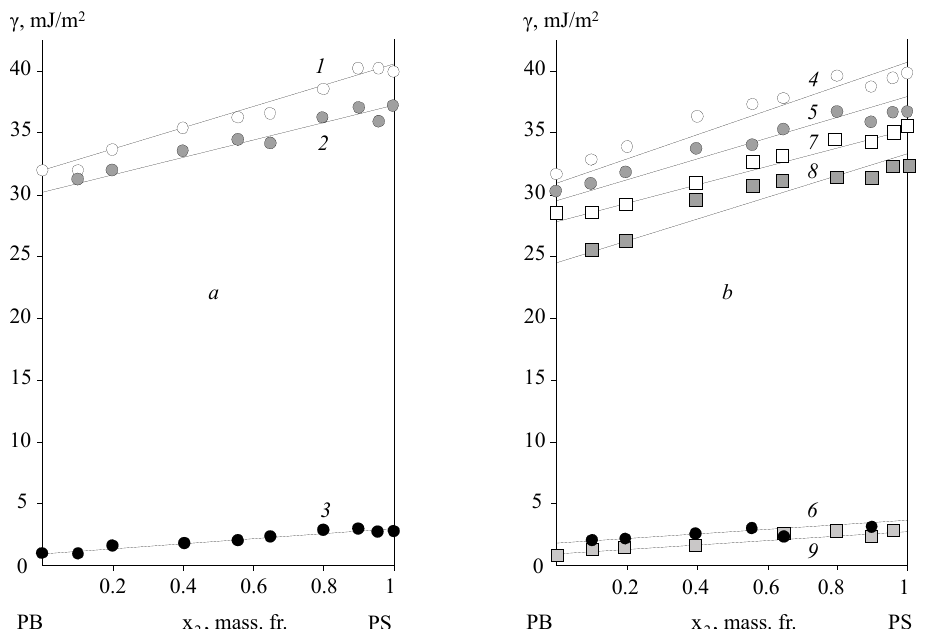
Figure 1. Dependence of the surface energy γ (1, 4, and 7) and its polar γ P (2, 5, and 8) and dispersion components γ D (3, 6, and 9) on the composition of BSC copolymers at 293 ± 1 K. BSC surface is formed on the: ( a ) air—(1, 2, and 3), and ( b ) aluminium—(4, 5, and 6) and PTFE—(7, 8, and 9).